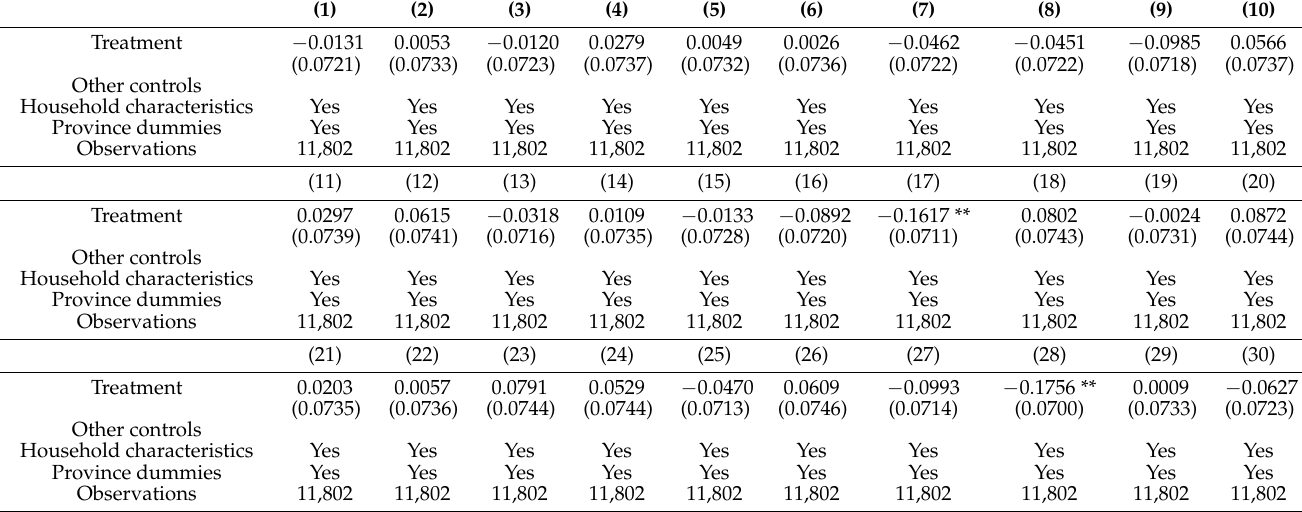
Table 5. Falsification test: random assignments of